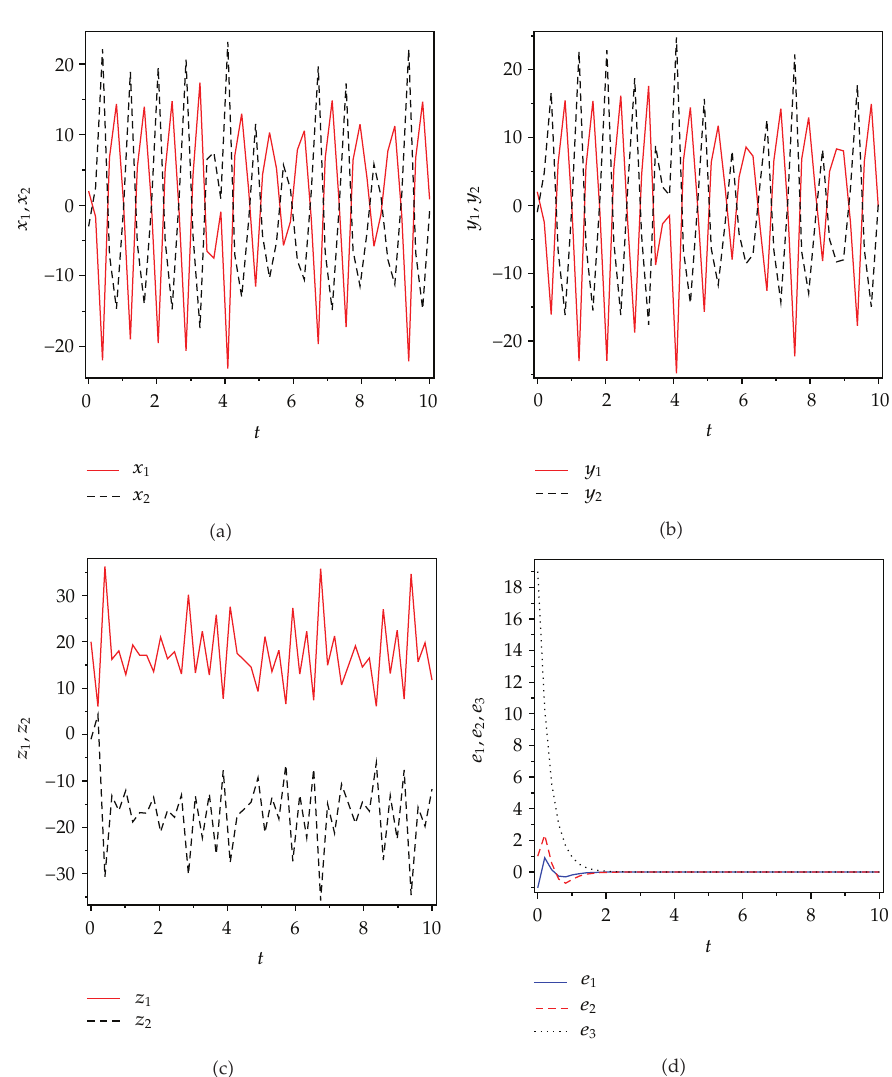
,e , e 1 2 3 between two identical L¨u systems with